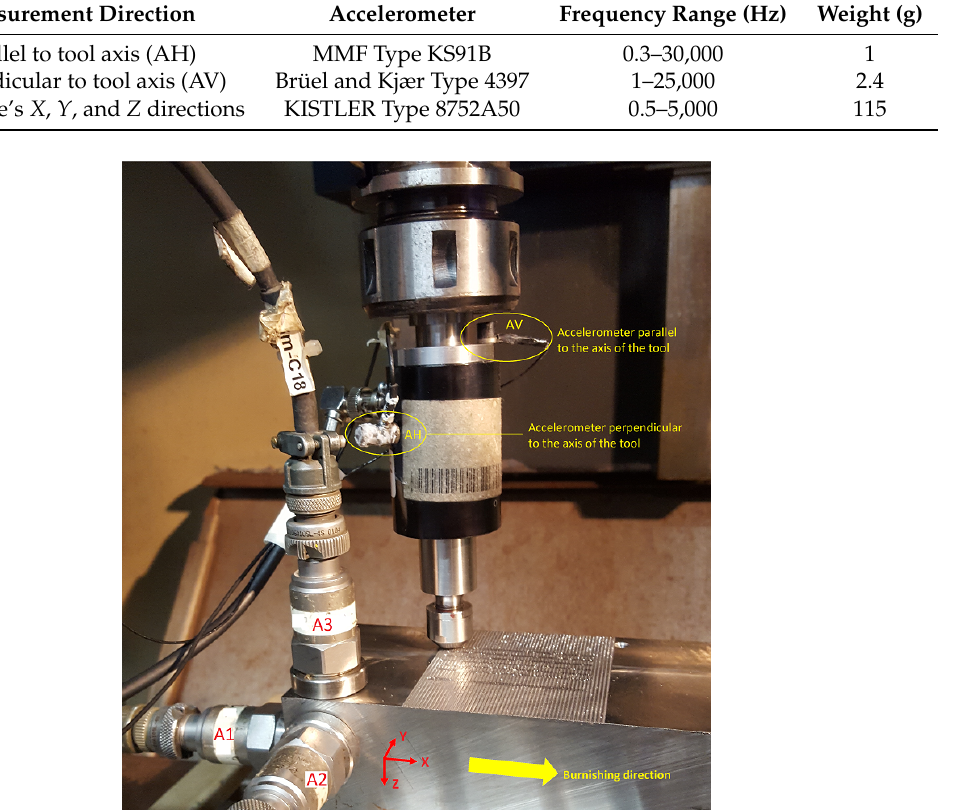
Figure 3. Experimental setup of accelerometers on the workpiece (A1, A2, and A3) and on the tool (AV and